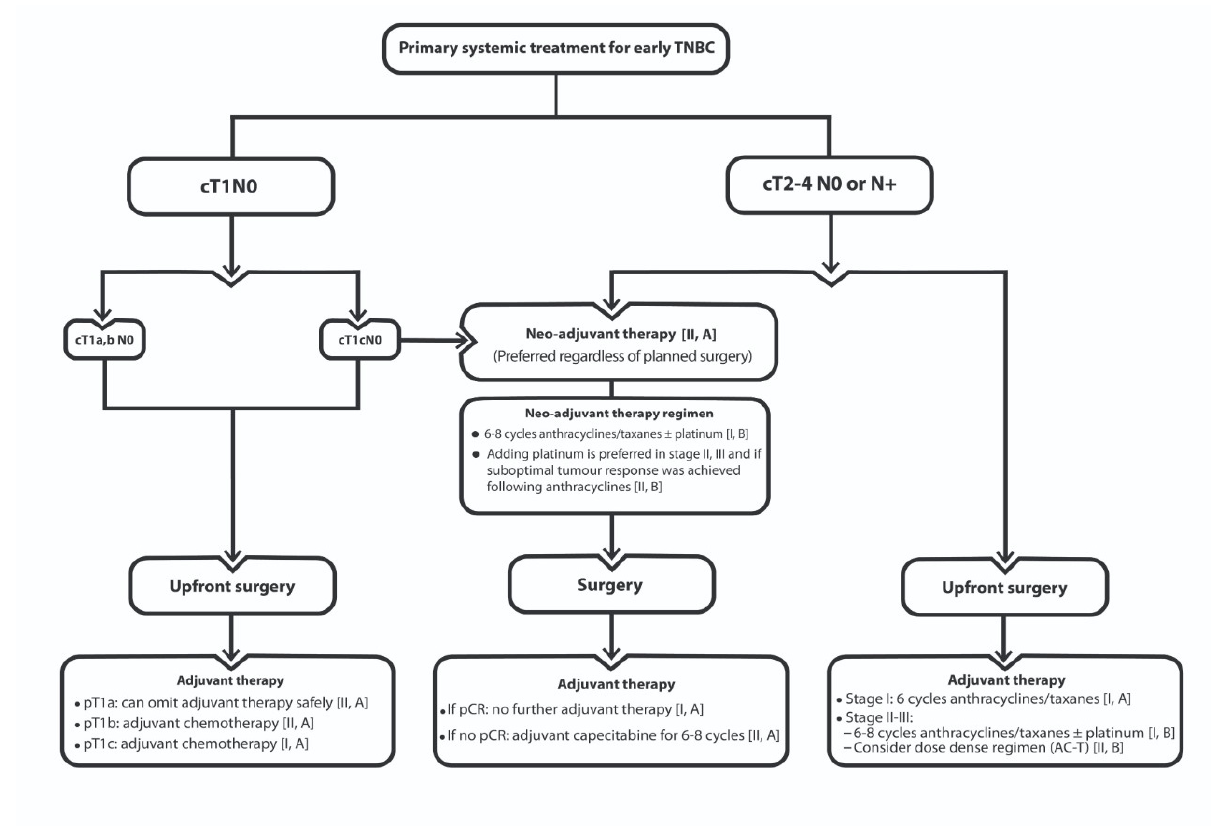
Figure 1. Primary systemic therapy algorithm for early TNBC.